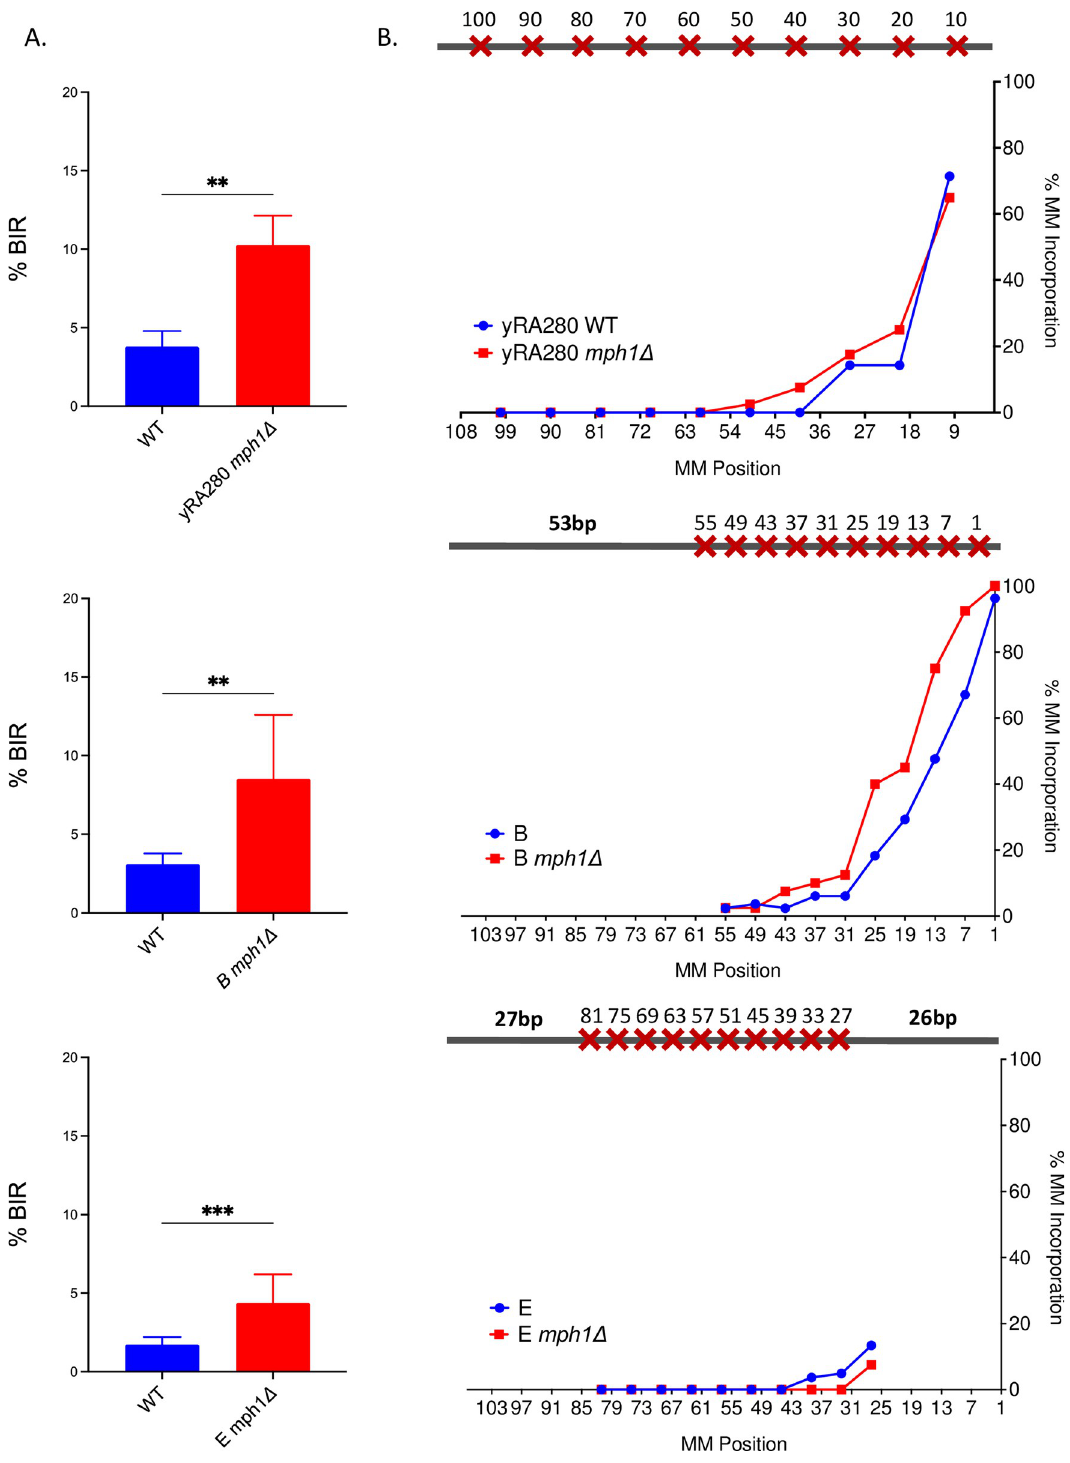
Fig 9. DNA helicase Mph1 suppresses BIR efficiency. A. The effect of deleting the DNA helicase Mph1 on BIR efficiency for yRA280 and donor templates B and E. Welch’s t-test was used to determine the p-value. Error bars refer to standard error of the mean. A minimum of at least five measurements were performed. B. The effect of deleting Mph1 on mismatch incorporation pattern for yRA280, donor templates B and E. For all % mismatch incorporation data, a minimum of 40 samples were DNA sequenced.